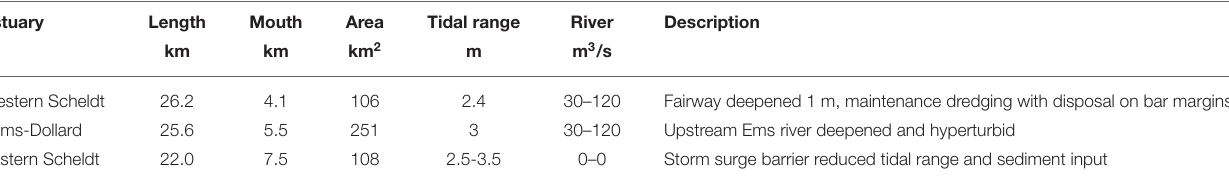
TABLE 1 | Key characteristics of the three estuaries: length of channel centerline (also shown in Figure 4 , total mapped area (without the water class), spring-tidal range at the mouth, mean and maximum river discharge and general description (see text). Estuary